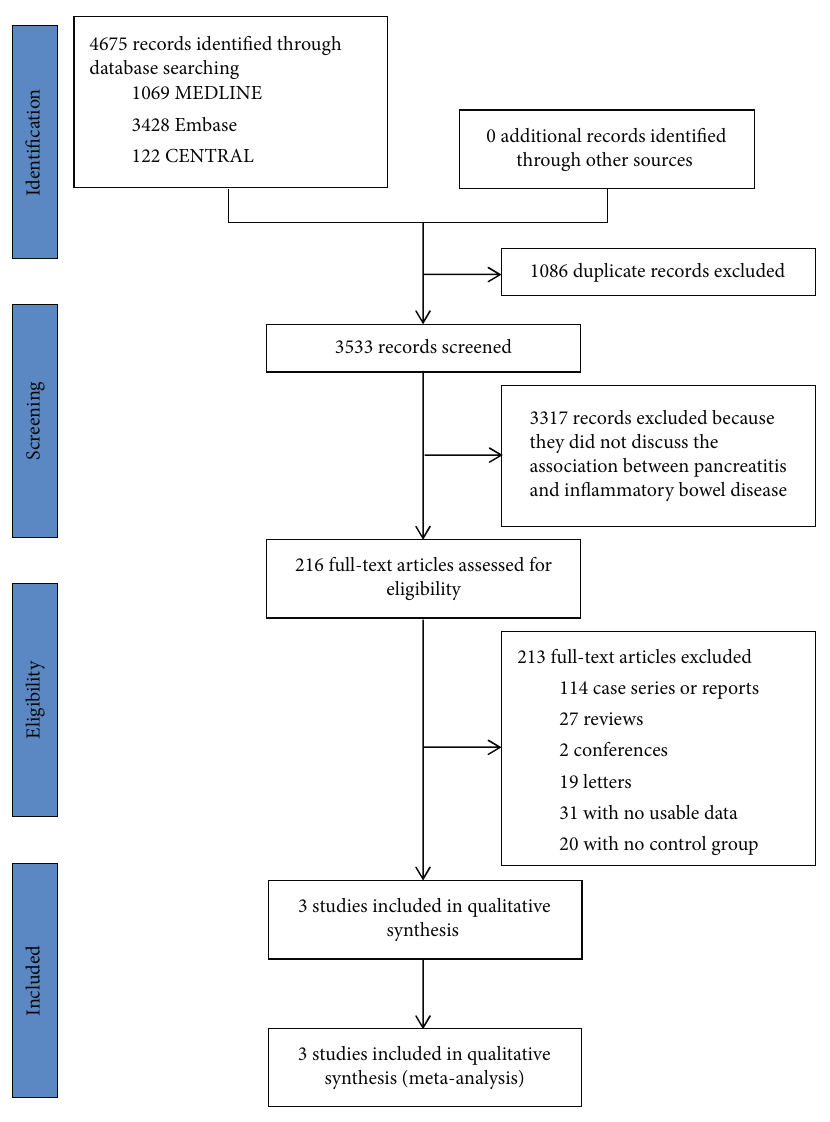
Figure 1: PRISMA study fl